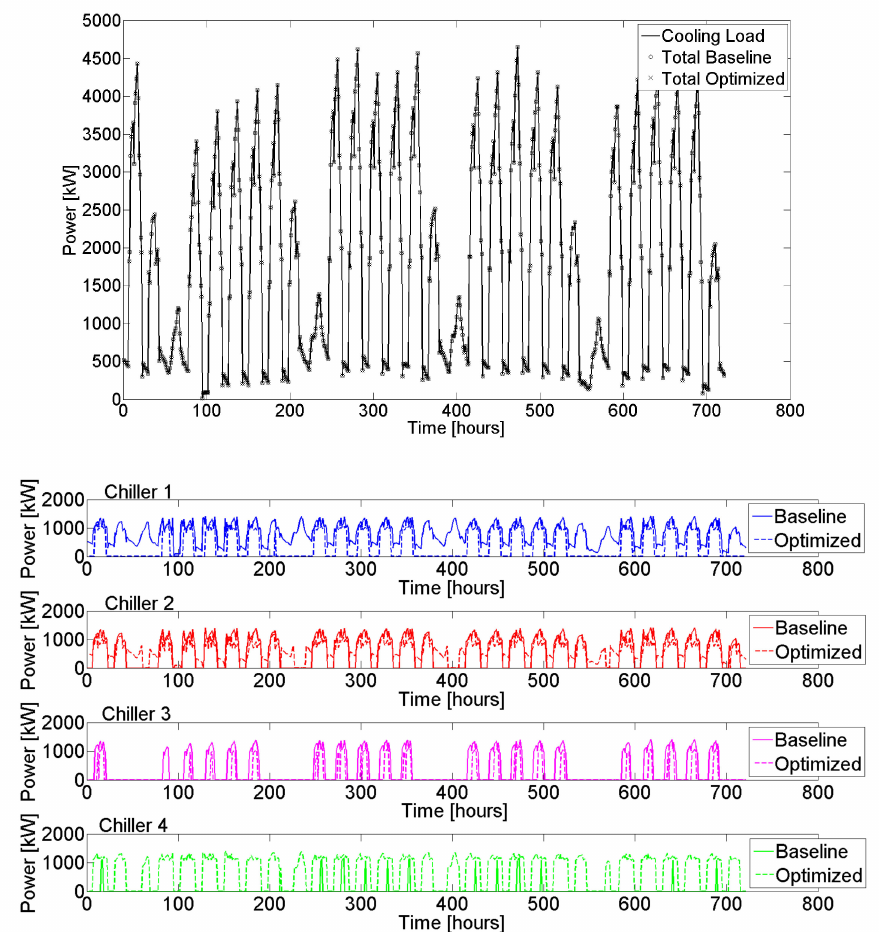
Figure 11. Optimized sequencing control applied on a cooling load obtained from EnergyPlus